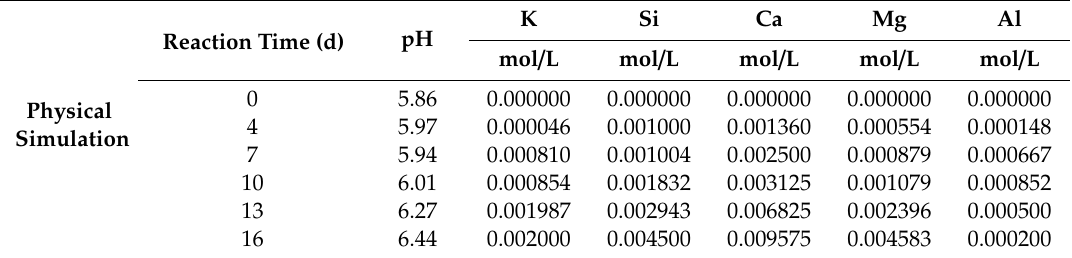
Table 3. Chemical composition of outlet